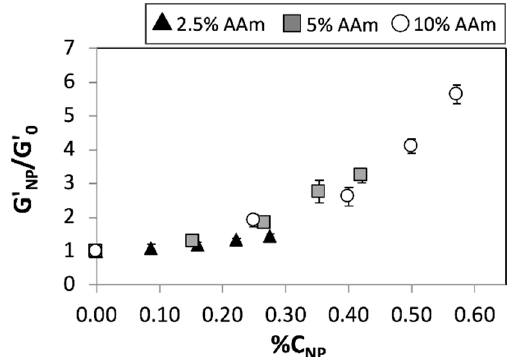
Figure 4. Relative elastic moduli of 2.5% pAAm (white circles), 5% pAAm (grey squares), and 10% pAAm (black triangles) hydrogels prepared using % C Bis = 4.76 as a function of relative nanoparticle concentration (% C NP ). Data shown are the mean of triplicate measurements ± standard deviation and have been repeated at least three times with similar results.